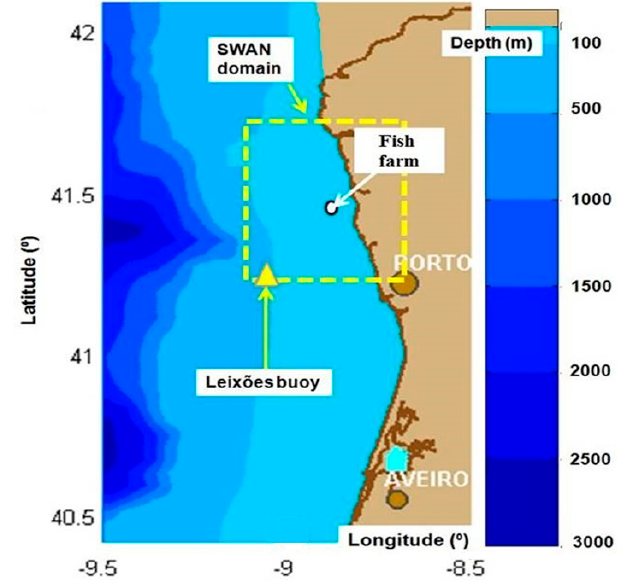
Figure 1. The bathymetry of the northern part of the Portuguese nearshore is illustrated in the background, while in the foreground, the location of the fish farm is indicated, together with the geographical space of the SWAN computational domain and the position corresponding to the Leixões buoy.